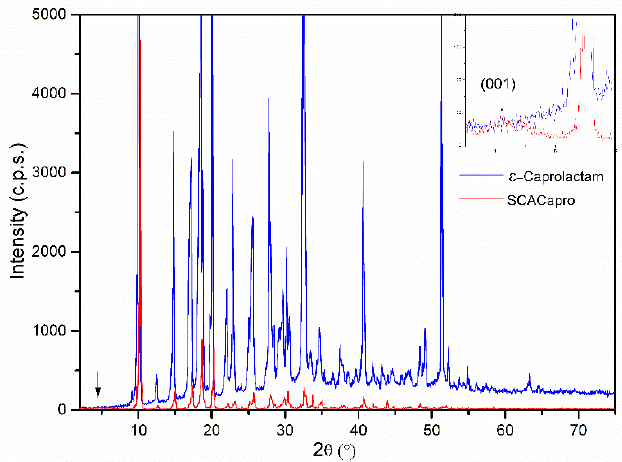
Figure 5. PXRD diagrams of commercial ε –caprolactam and of sample SCACapro.